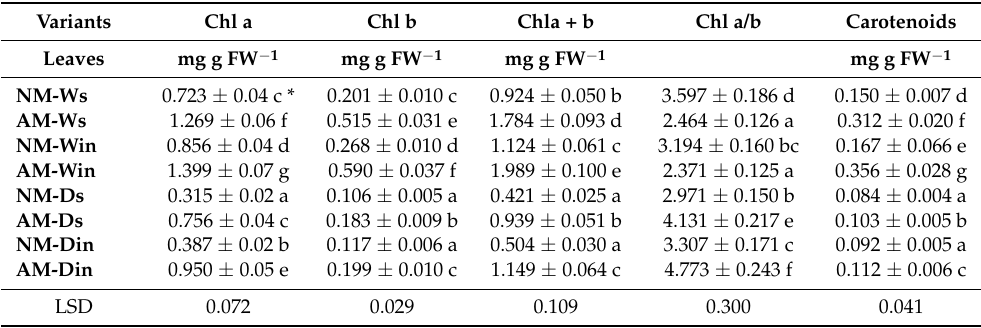
Table 2. Photosynthetic pigments Chl a, Chl b, and carotenoids in P. peruviana leaves: non-mycorrhizal ( NM ), AMF-inoculated ( AM ), well-watered ( W ), drought-stressed ( D ), from seed-propagated ( s ), and in vitro propagated ( in ) plants. Variants Chl a Chl b Chla + b Chl a/b Carotenoids